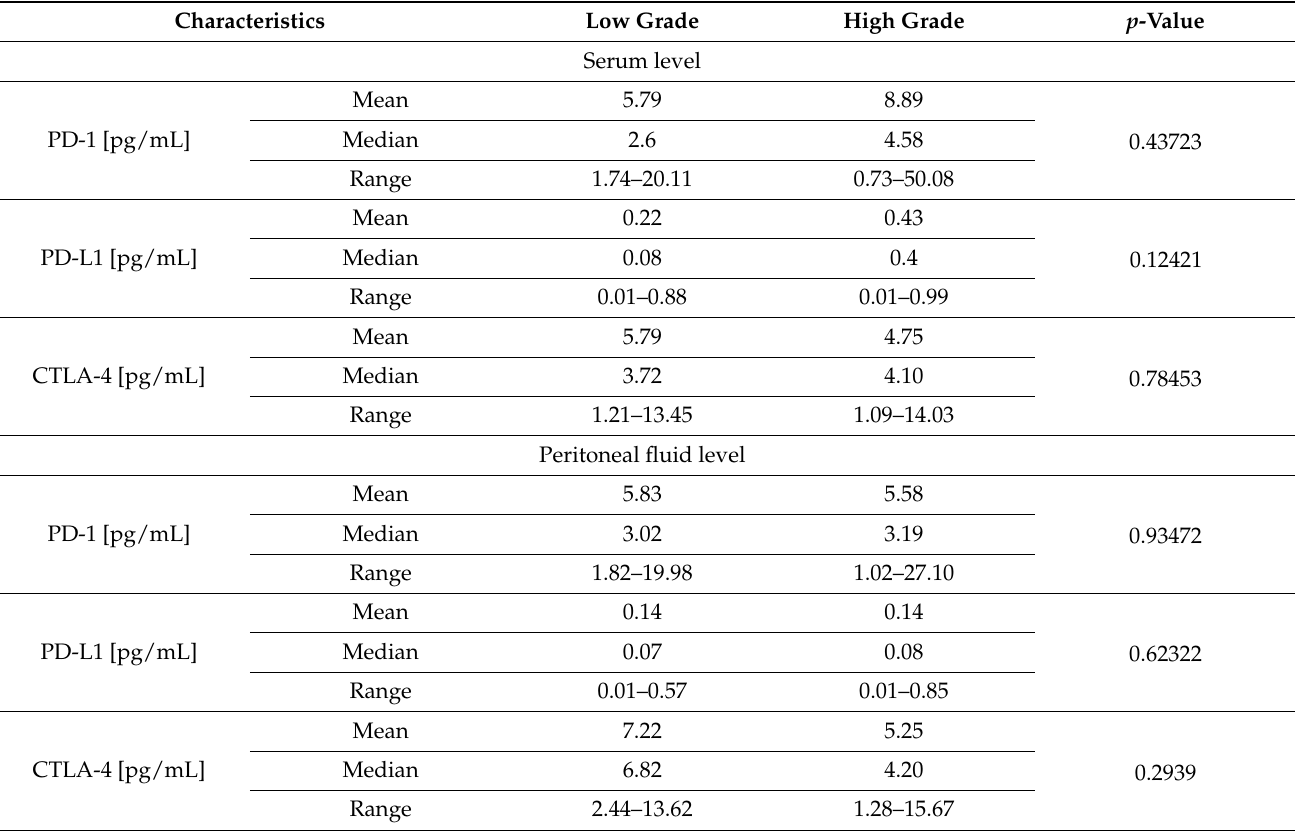
Table 5. Levels of serum and peritoneal fluid concentrations of the studied proteins in the compared grading